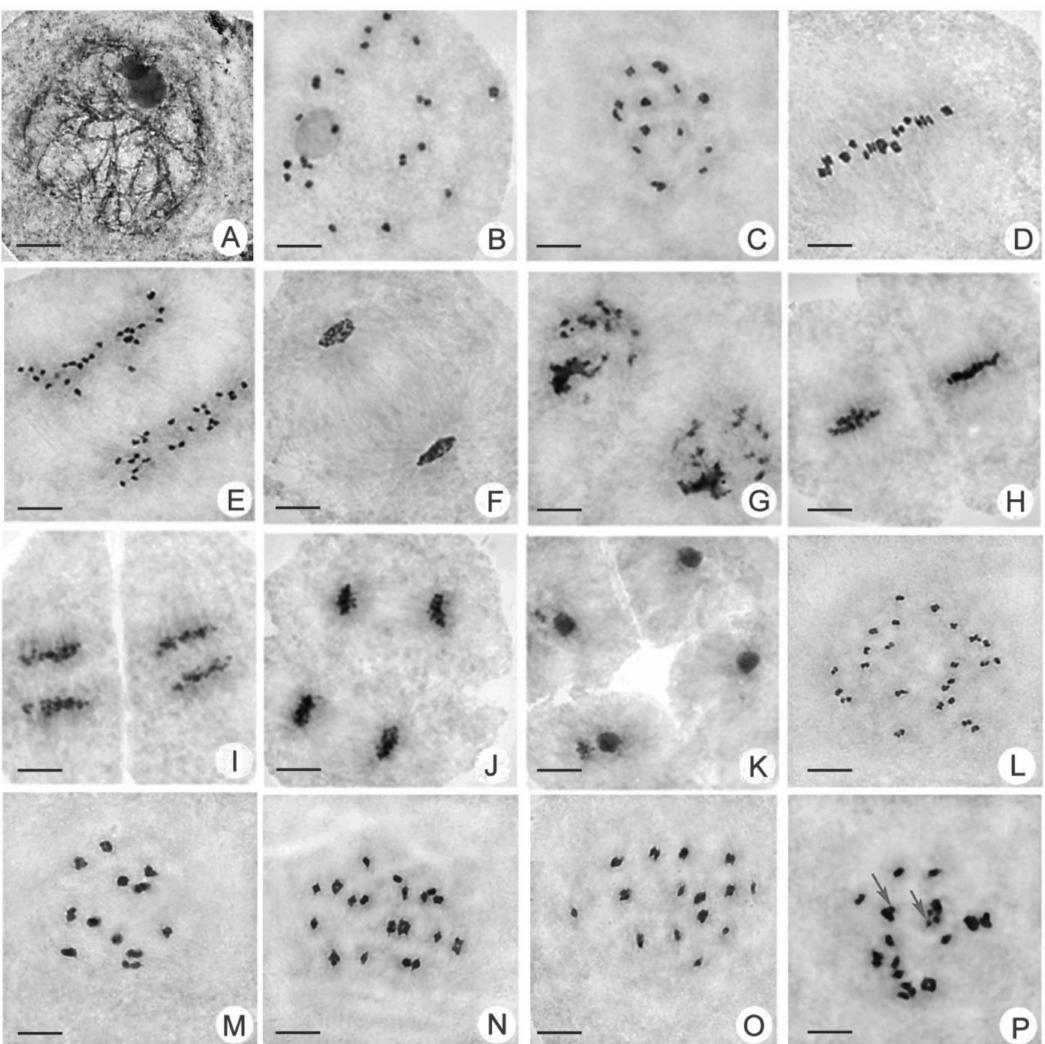
Figure 3. Chromosome behaviors and chromosome configurations in H1 and its parents during PMC meiosis ( × 3000). ( A ) Zygotene. ( B ) Diakinesis. ( C ) Diakinesis. ( D ) Metaphase I. ( E ) Anaphase I. ( F ) Telophase I. ( G ) Prophase II. ( H ) Metaphase II. ( I ) Anaphase II. ( J ) Telophase II. ( K ) Tetrad stage. ( L ) Diakinesis, 24 II. ( M ) Diakinesis, 12 IV. ( N ) Diakinesis, 7 IV + 10II. ( O ) Diakinesis, 9 IV + 6II. ( P ) Diakinesis, univalent (arrow). Bars = 10 µ